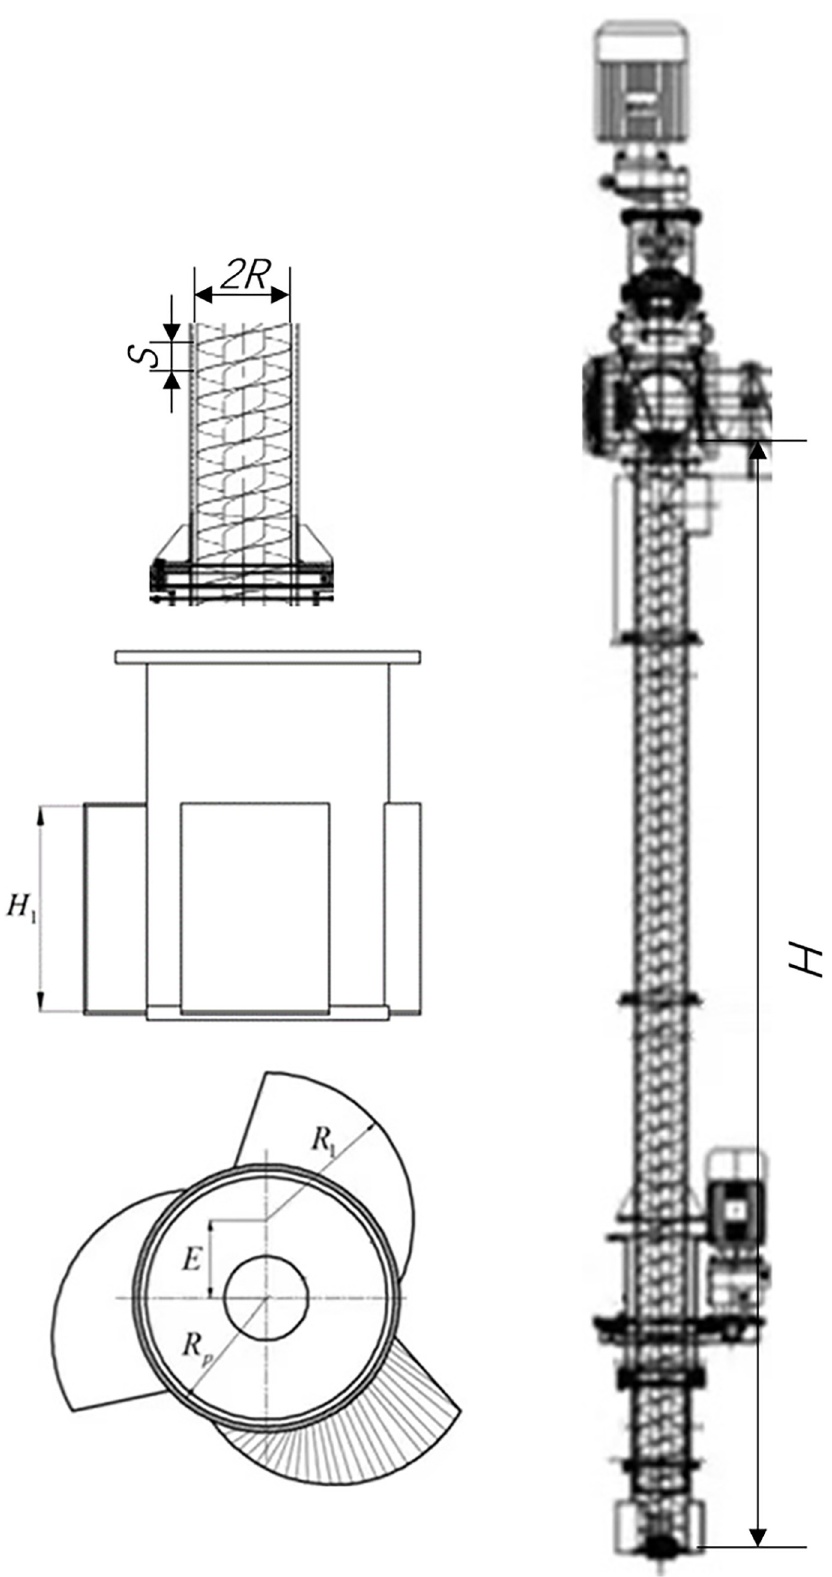
Fig 1. Structure of the vertical screw